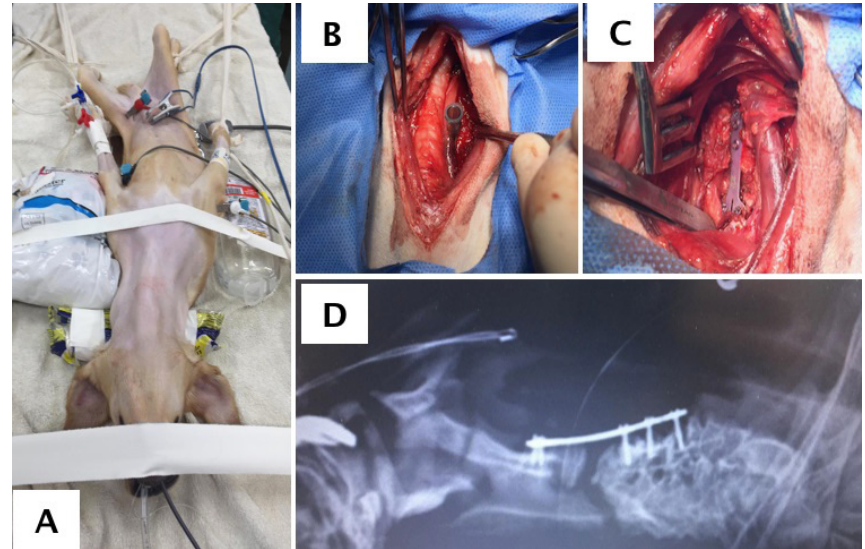
Figure 6. Surgical procedure to stabilize the cervical dynamic instability (C2-C3 vertebrae) in a 3-month-old male MBD dog with congenital vertebral malformations (Veterinary Hospital/UFRRJ –